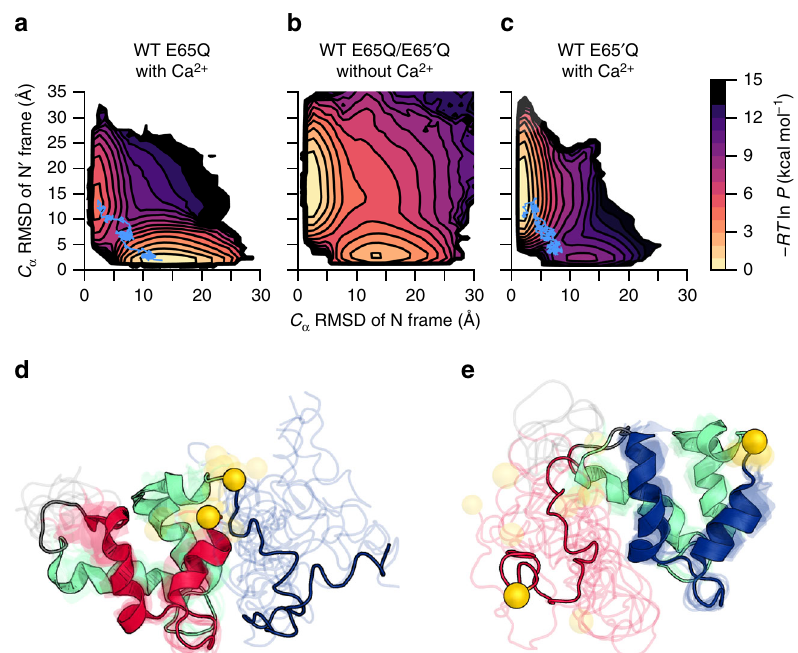
Fig. 2 Thermodynamic and structural properties of the calbindin-AFF switch. a – c Free energy surfaces of the switching process as a function of the C α RMSDs of the N and N ′ frames from their corresponding folded conformations for ( a ) the WT E65Q construct with Ca 2 + , ( b ) the WT E65Q/E65 ′ Q construct without Ca 2 + , and ( c ) the WT E65 ′ Q construct with Ca 2 + . Each free-energy surface represents a total of 20 WE simulations and thousands of independent switching pathways. The color scale represents − RT ln P , where P is the equilibrium probability density (see Supplementary Methods). Upper left and lower right basins correspond to the N and N ′ folded states, respectively. Representative transition paths in a and c are highlighted in blue and correspond to Supplementary Movies 1 and 2, respectively. See Supplementary Fig. 5 for a representative binning scheme used during the simulation of ( a - c ). d , e Representative Ca 2 + -bound conformations of the N ′ folded state of the WT E65Q construct ( d ) and N folded state of the WT E65 ′ Q construct ( e ) are well-folded with partially disordered orphan EF-hands (see Fig. 1a for color scheme; yellow spheres indicate positions at which fl uorophores were inserted in the stopped- fl ow fl uorescence experiments; fl uorophores were not included in the Fig. 6 for the advantages of analyzing the TPE vs. transition state